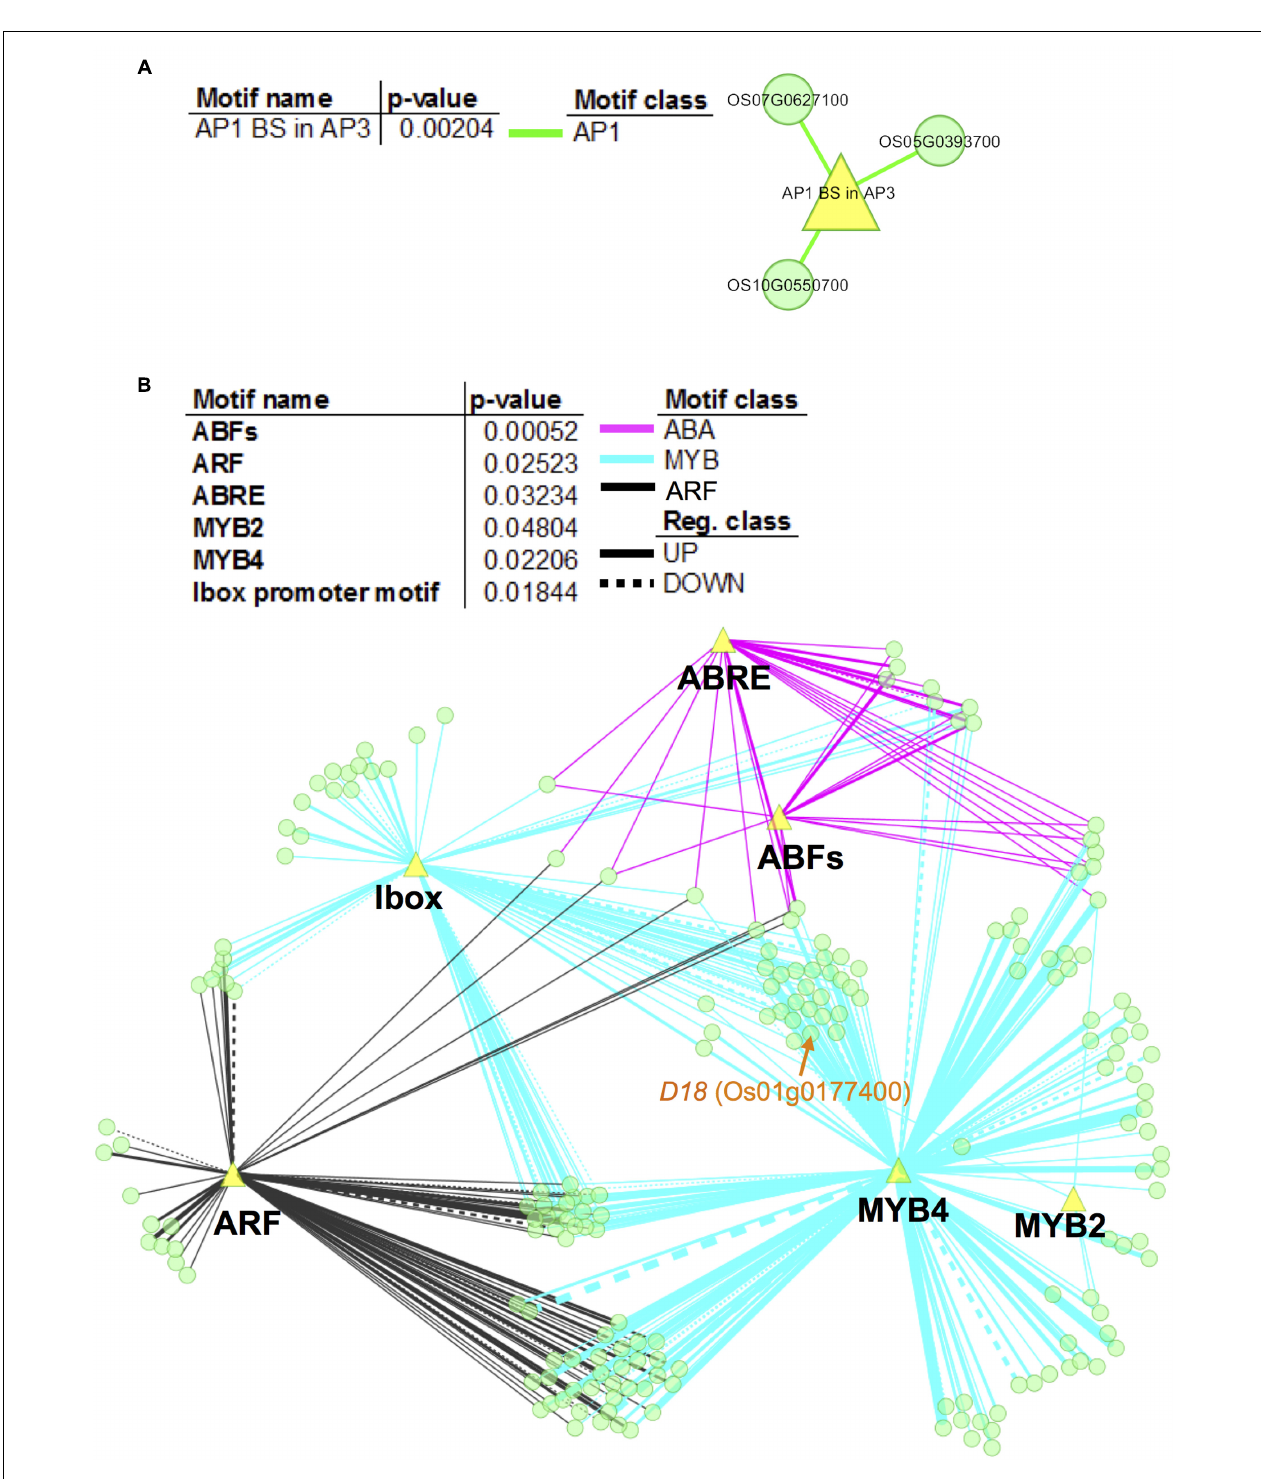
FIGURE 6 | Network visualization of enriched motifs and genes with trans -eQTLs hotspots. We performed promoter enrichment analysis for promoters of e-traits that feature trans -eQTL at physical position “c4.loc24” on chromosome 4 (A) and “c12.loc25.5” on chromosome 12 (B) . Significantly enriched motifs were listed in the tables ( p < 0.05). The enrichment of different types of motif is visualized in colors representing the motif class. The network represents the relationship between evaluated genes and the enriched motifs (yellow triangles). Network nodes (green) indicate genes. Motif classes are as follows: yellow green, AP1; magenta, ABA; black, ARF; and cyan, MYB. Edge thickness is proportional to the number of motifs that exist in the promoters of the respective genes. Note that the analysis showed no significant motifs in 55 e-traits on chromosome 1.